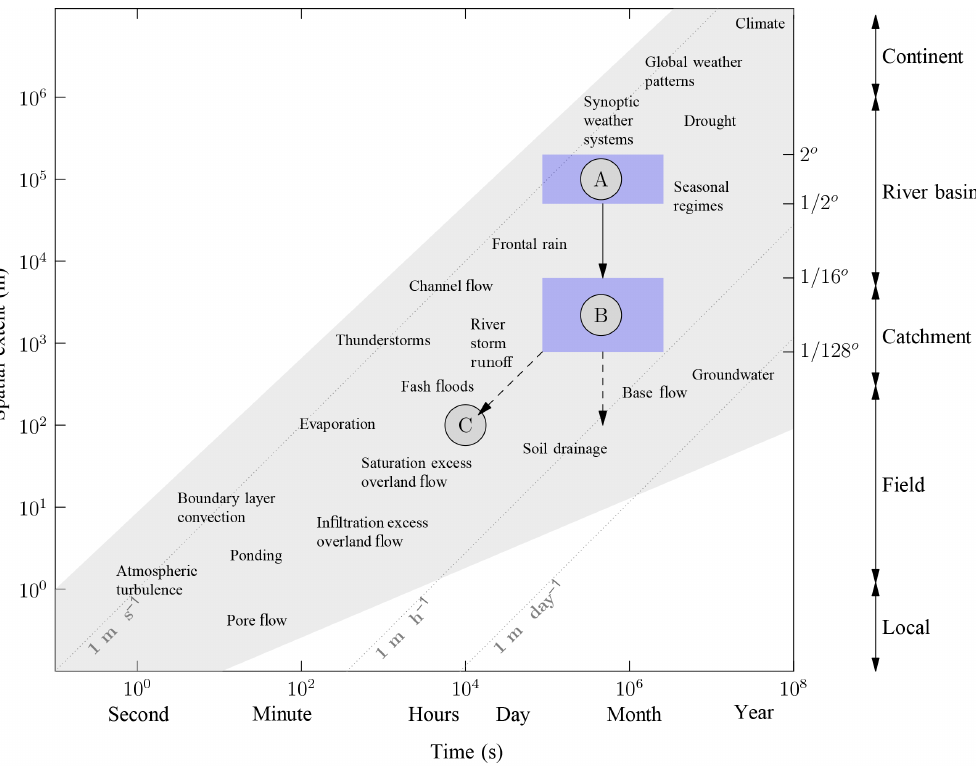
Figure 1. The timescales and space scales of several hydrometeorological processes. Adapted from Brutsaert (2005) and Blöschl and Siva- palan (1995), who based it on Orlanski (1975), Dunne (1978), Fortak (1982), and Anderson and Burt (1990). The blue areas indicate the temporal and spatial resolution at which the VIC model has been applied, when it was initially developed (A) and presently (B). The dashed arrow pointing downwards shows the ambitions of spatial hyper-resolution modelling, whereas the dashed arrow pointing towards (C) shows the temporal and spatial resolution of hyper-resolution modelling if it follows the direction of characteristic velocity of hydrometeorological